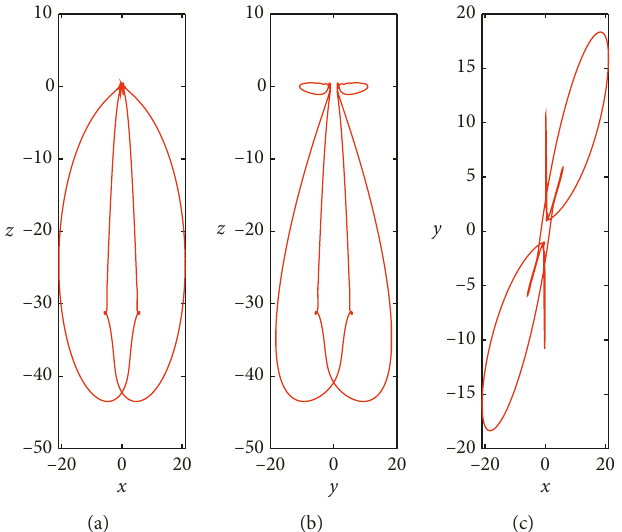
Figure 4: Periodic phase portraits of system (2) with a � − 1: (a) in the x − z plane, (b) in the y − z plane, and (c) in the x − y plane.